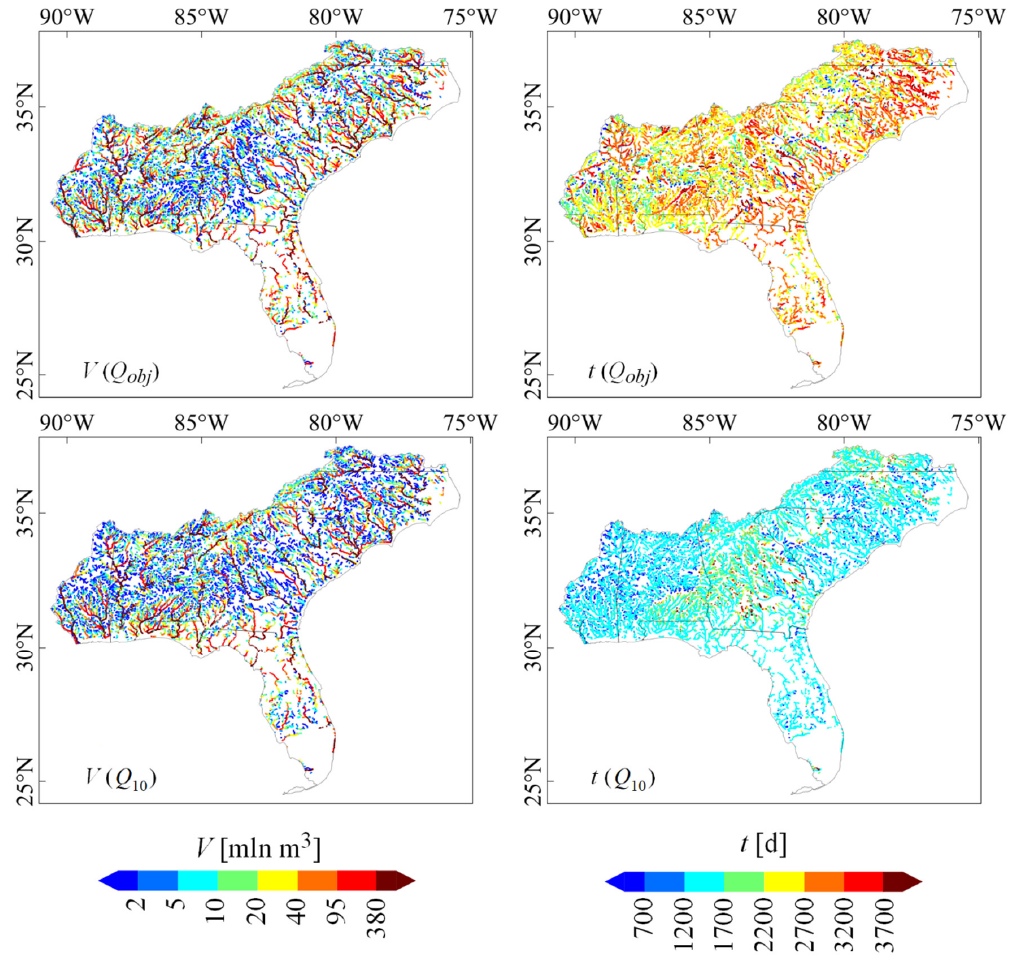
Figure 9. Spatial variability of volumes ( V ) and duration time ( t ) of low flows at each node, according to stream order and the threshold method used.